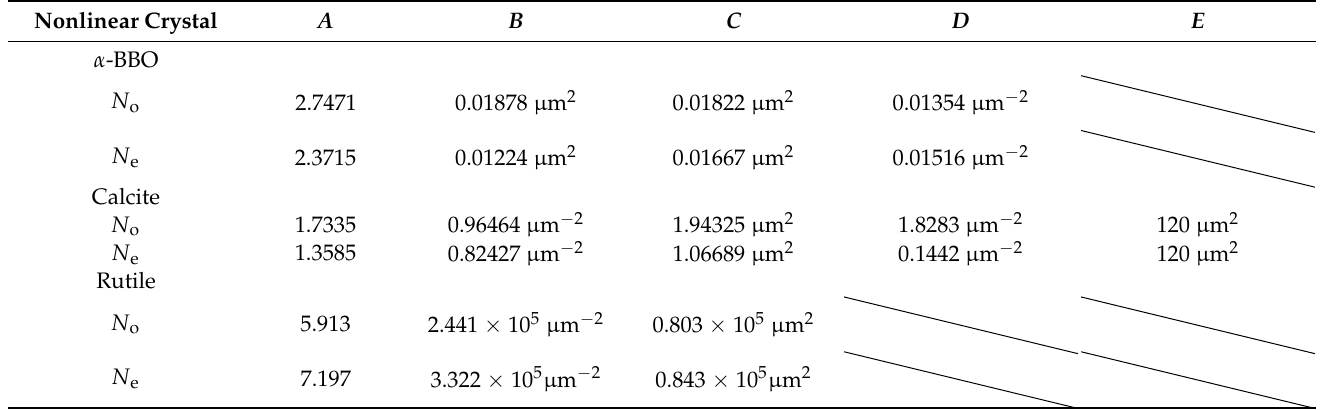
Table 1. The coefficients of Sellmeier Equations